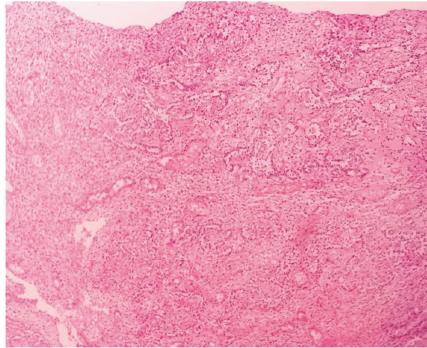
Figure 3: Hematoxylin-eosin, magnification 200x, clear cell cords resembling ovarian sex